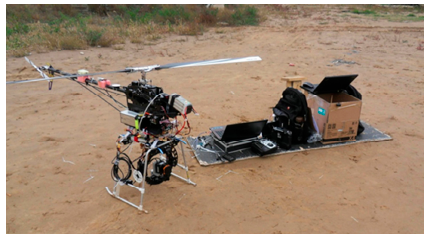
Figure 1. Hardware platform for the data acquisition.